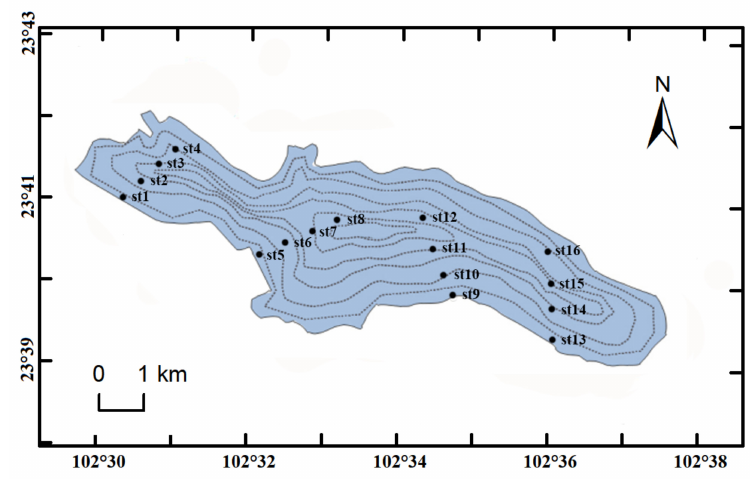
Figure 2. The distribution of sampling sites in Yilong